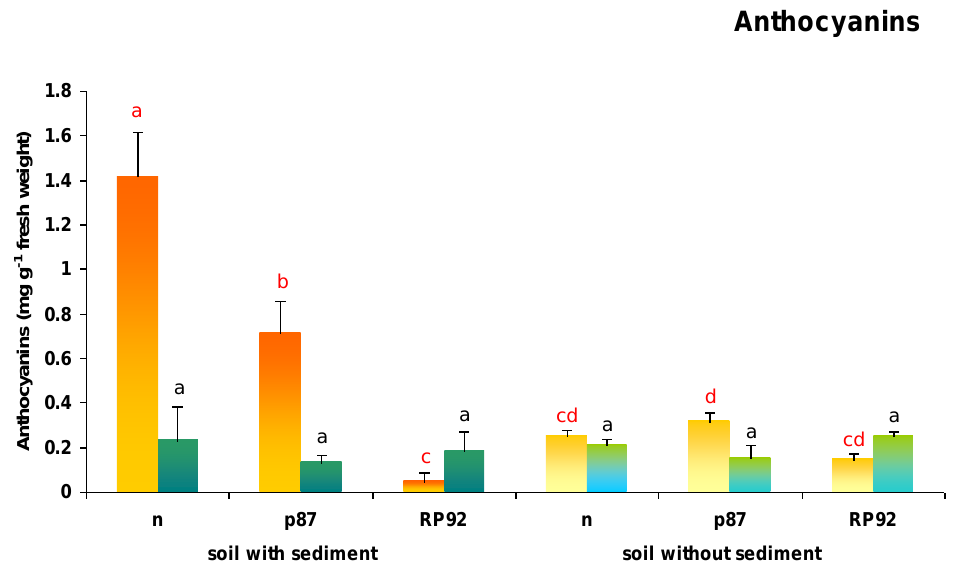
Figure 9. Anthocyanins content in leaves of T. patula and F. arundinacea grown on control and bottom sediment-amended soil with or without (n) inoculation with bacterial strain p87 or RP92. The same letters denote groups that did not significantly differ (at p < 0.05; the Duncan post hoc test). Statistical significance was measured for each plant separately and the results were marked by different colors.